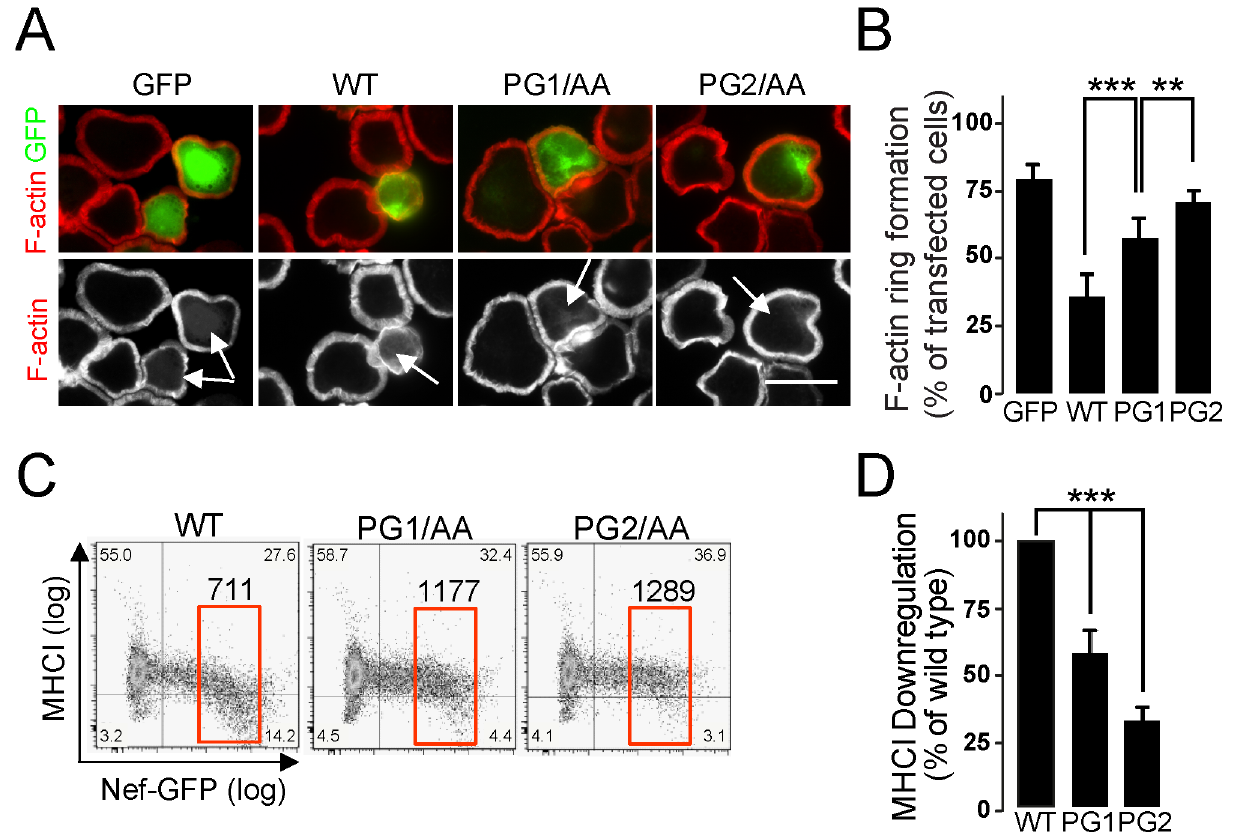
Fig 6. GPG-mutations reduce Nef-dependent inhibition of TCR-induced actin remodelling and Nef-induced down-regulation of MHCI. (A-B) Fluorescent microscopy of Jurkat T-cells transfected with the indicated GFP or Nef-GFP expression plasmids after 5 min incubation on anti-CD3 coated cover glasses and subsequent staining for F-actin. A) Depicted pictures are a representative image at the cell-cover glass level. The upper panel presents a merge of the GFP and F-actin channels, the lower panel shows the F-actin channel only. Arrows indicate transfected cells. Scale bar, 10 μ m. B) Quantification of the experiment shown in A. Shown is the percentage of cells exhibiting pronounced F-actin ring formation. Values are the arithmetic mean ± SD of at least three independent experiments in which over 100 cells were counted per condition. *** , p < 0.001. (C-D) CEM cells were transfected with the wild type or the indicated Nef-GPG mutants as GFP-fusion proteins. Nef-induced surface MHCI down-regulation was assessed by flow cytometry in Nef-GFP expressing cells. C) Dot plots and the corresponding MFI are representative of three independent assays. D) The mean fluorescence intensity (MFI) of MHCI (Alexa-555) in the GFP-positive cells was used to calculate activity relative to wild-type Nef. Values are the arithmetic mean ± SD of at least three independent experiments. ** , p < 0.01; *** , p <